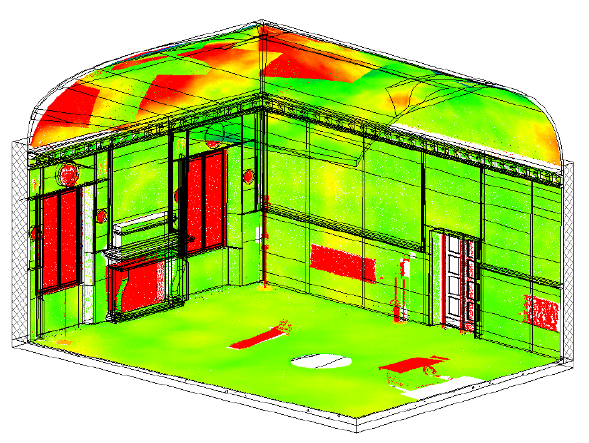
Figure 6: Axonometric view with the point cloud of geometric model